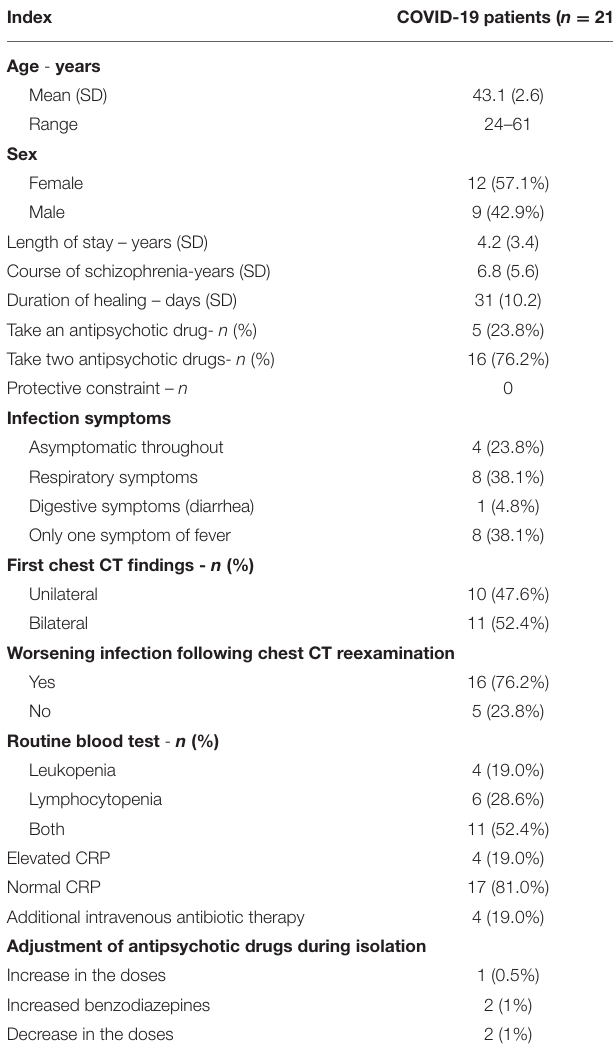
TABLE 1 | Clinical characteristics of schizophrenia patients with